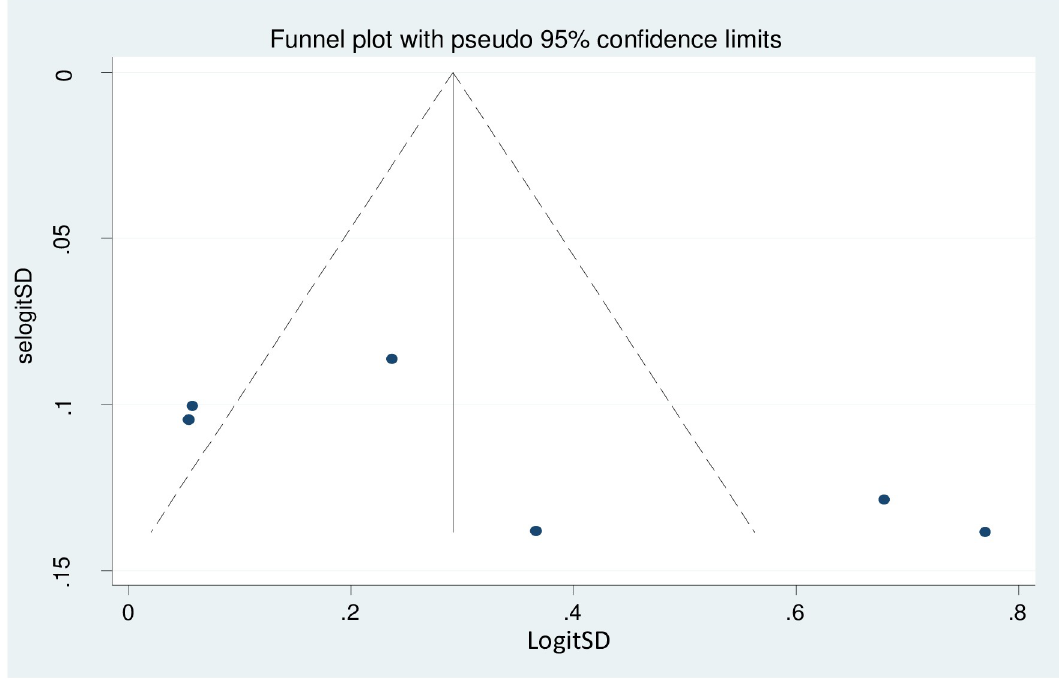
Fig 4. Funnel plot of effect estimates against standard error of log